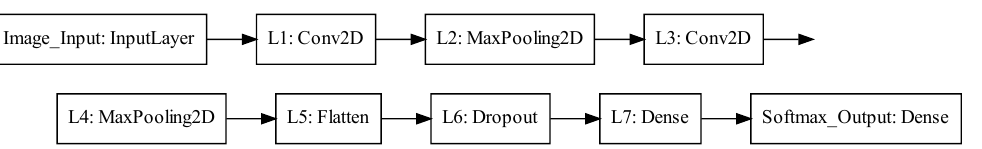
Figure 6. The displayed CNN model was used for the indoor self-driving task.